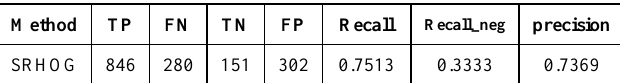
Table 2. SRHOG Performance on INRIA